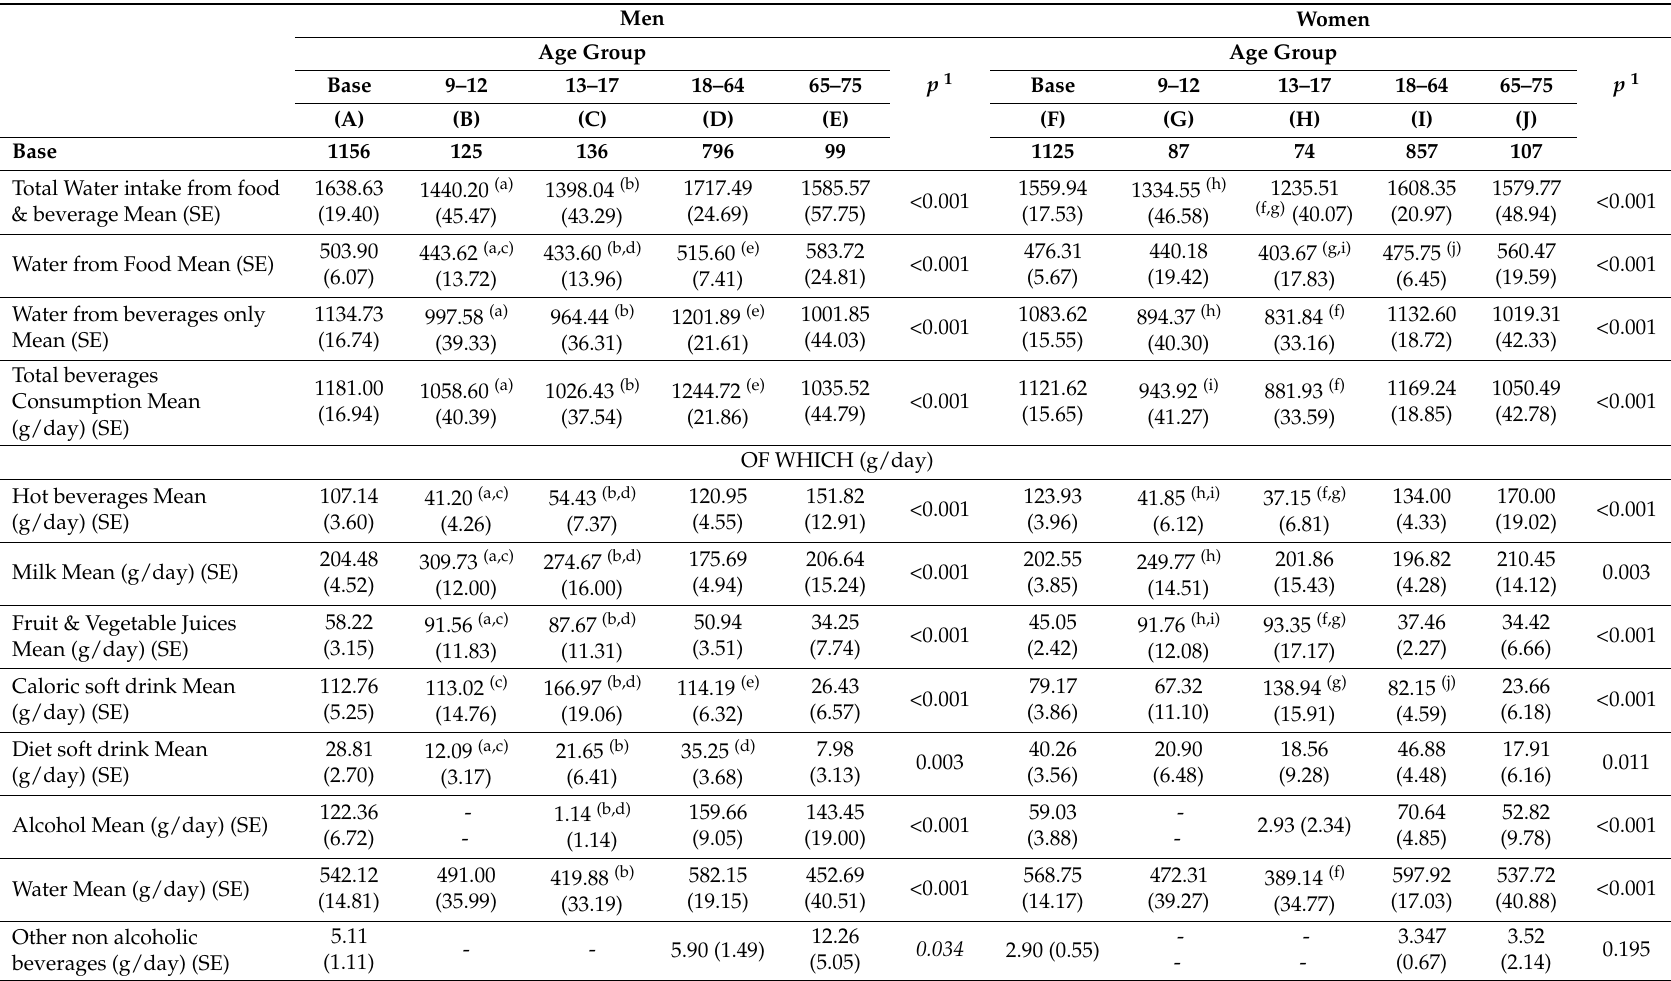
Table 3. Total water intake and beverage consumption (g/day) by sex and age group ( n =